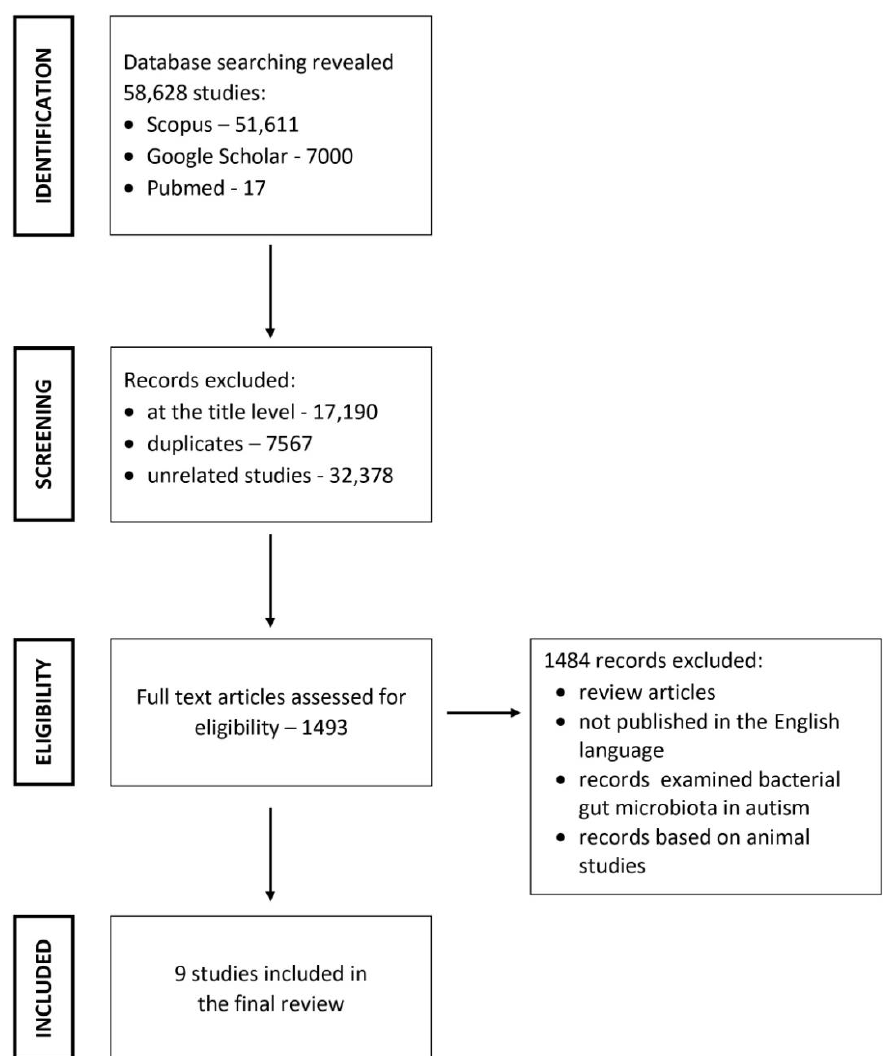
Figure 1. Search strategy used to identify relevant